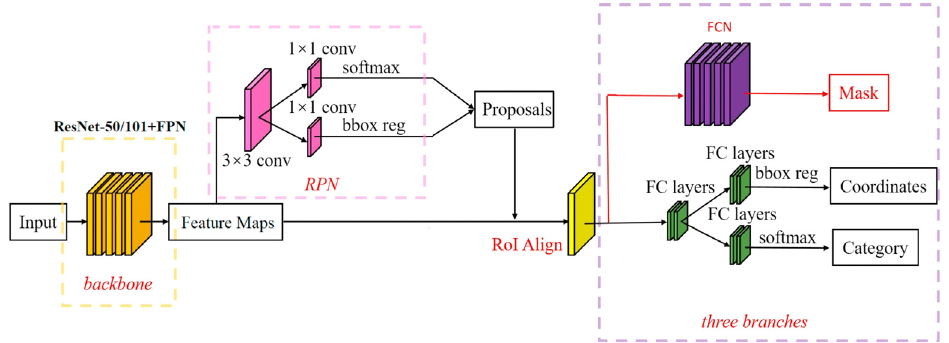
Figure 5. The network structure of Mask R-CNN.